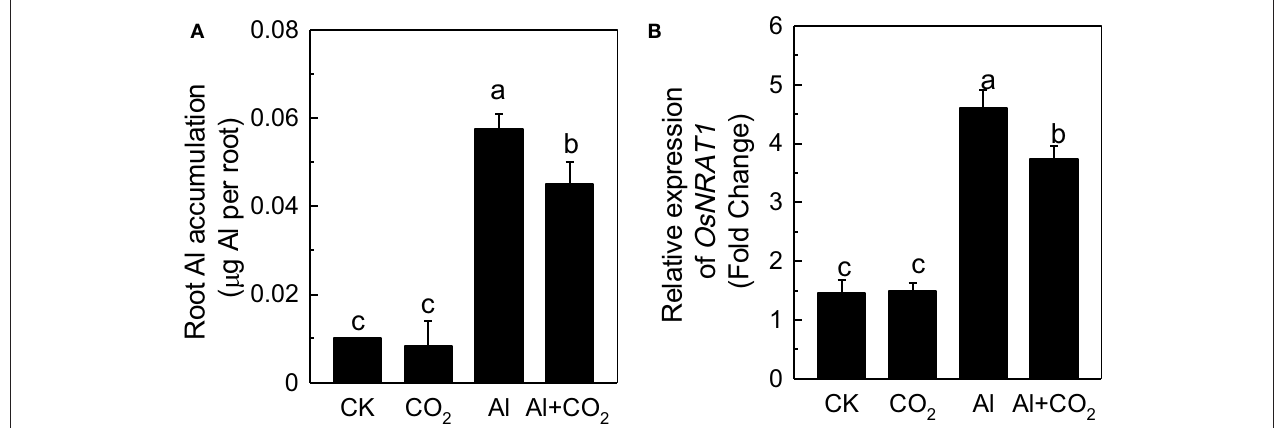
FIGURE 2 | Effects of elevated CO 2 on Al accumulation (A) and the expression of OsNRAT1 (B) in Kas roots. Three-day-old rice seedlings were treated with 0.5 mM CaCl 2 solution with or without 50 µ M Al under ambient (400 µ L · L − 1 ; CK) or elevated (600 µ L · L − 1 ; CO 2 ) CO 2 for 24 h (pH 4.5). The root apex was excised for Al content measurement (A) and for RNA extraction (B) . Expression levels of plants grown in ambient CO 2 without Al treatment were assigned as expression level of 1. Data are means ± SD ( n = 4). Columns with different letters are significantly different at P < 0.05.